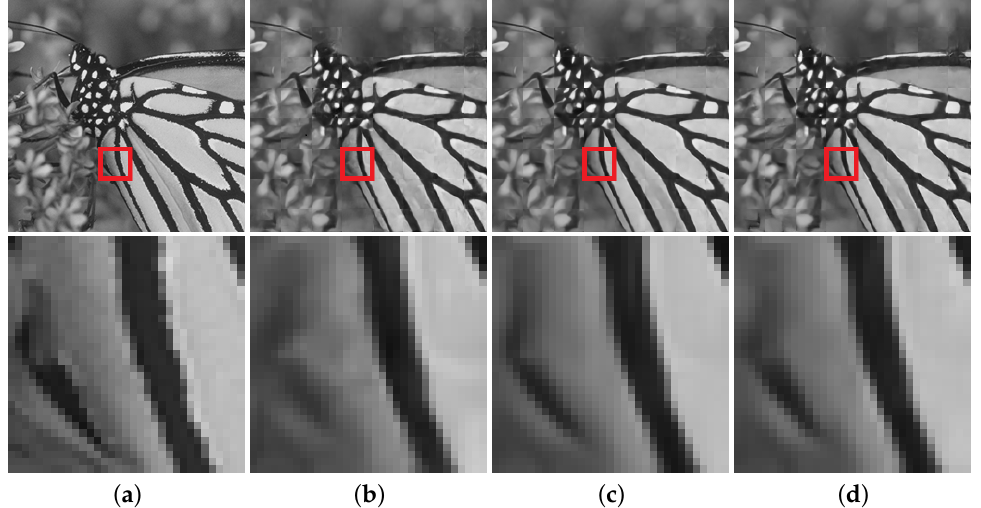
Figure 5. Reconstruction of a butterfly image with a CS ratio of 10% using the 9-phase ISTA-Net + (PSNR 25.91dB), 9-phase EPGN (26.47dB), and 7-phase NL-EPGN (26.58dB). ( a ) Ture. ( b ) ISTA-Net + . ( c ) EPGN. ( d ) NL-EPGN.